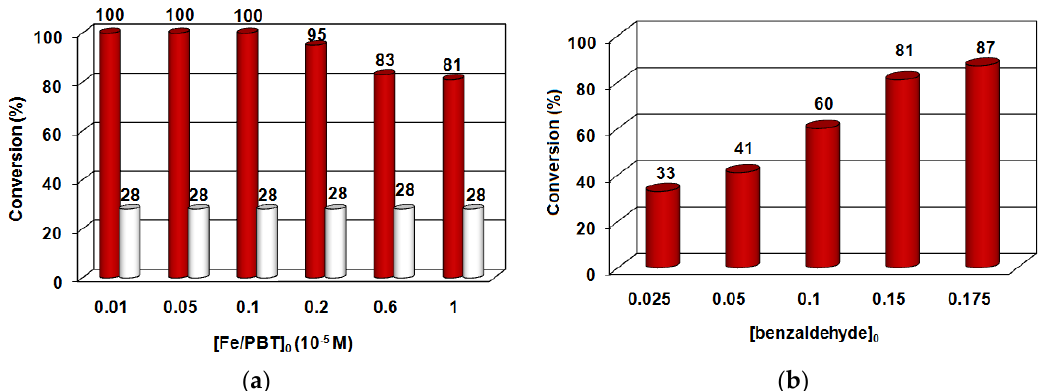
Figure 2. Preliminary kinetic study on the iron(II)-catalyzed Baeyer–Villiger oxidation of cyclohex- anone by molecular oxygen in the presence of benzaldehyde. ( a ) Plot of conversion versus catalyst ( 2 ) concentration; ( b ) Plot of conversion versus benzaldehyde concentration reaction conditions: [ 2 ] (0.01–1.0 × 10 − 2 mM), cyclohexanone (10 mM), benzaldehyde (25–175 mM), CH 3 CN (5 mL), O 2 bubbling, 60 °C, 15 h.